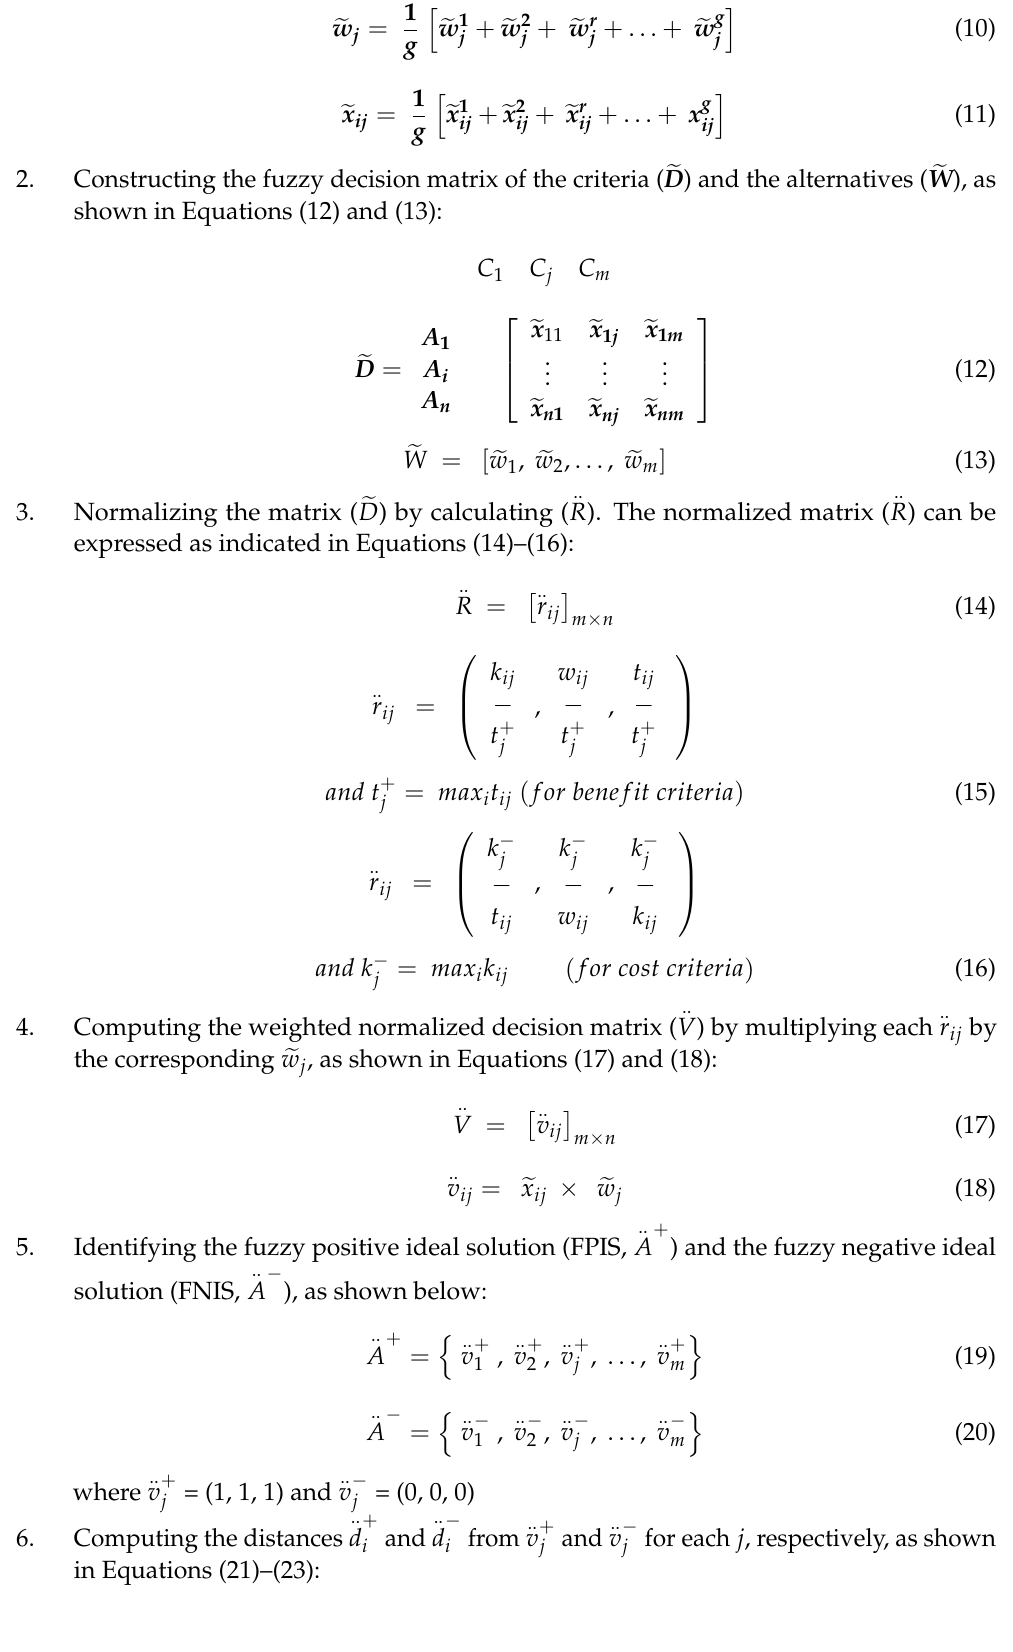
1. Aggregating the weights of the criteria and alternatives collected from k decision- makers, as shown in Equations (10) and (11):